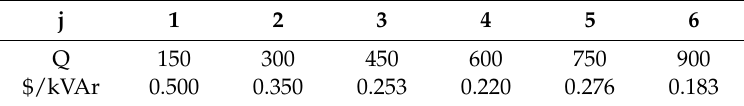
Table 13. Experiment result of ICSA over CSA in 33-bus system.